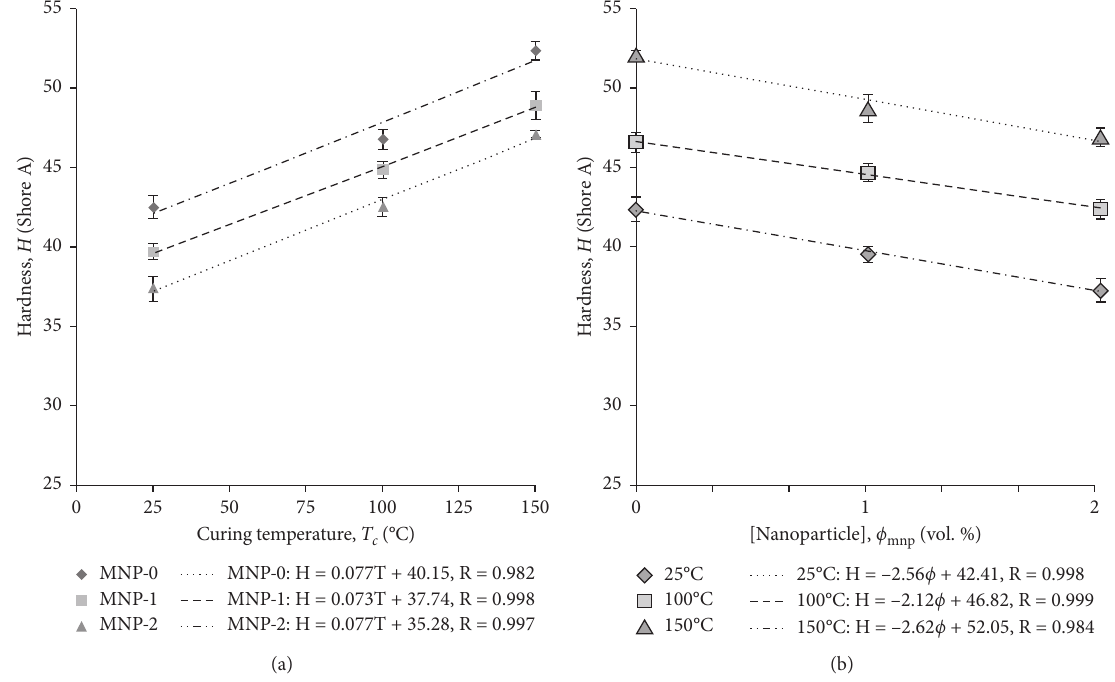
Figure 4: Hardness (Shore A), H , as a function of (a) curing temperature, T different T c